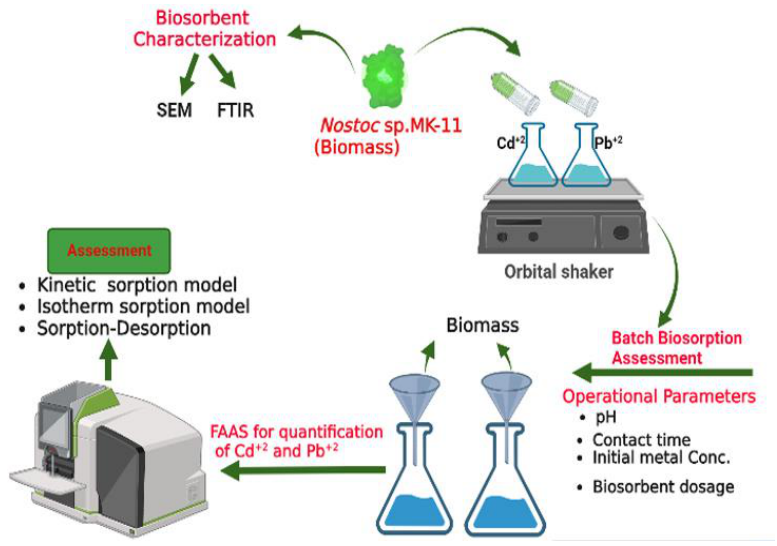
Figure 7. Pictorial representation of batch manner experiments to evaluate the biosorption of Pb and Cd ions using Nostoc sp. MK-11 as a biosorbent. Cd ions using Nostoc sp. MK-11 as a